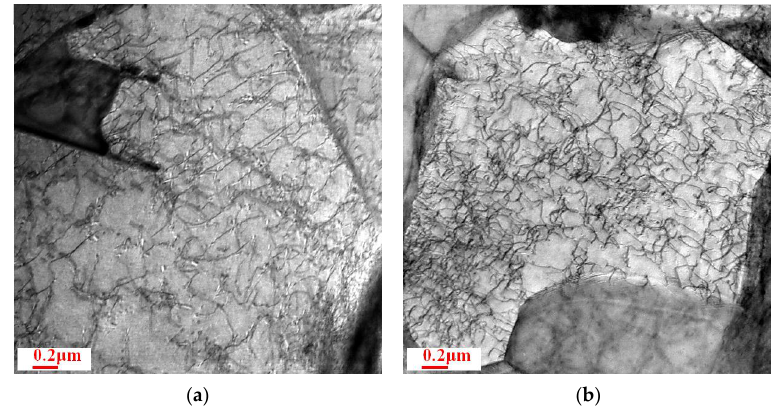
Figure 6. Dislocation distribution in the FZ of TWBs: ( a ) before and ( b ) after the magnetic treatment. In order to exhibit the distribution of dislocations, the enlarged images at local positions A and B are shown at the top right corner of each photograph. FZ: fusion zone; TWBs: laser tailor welded blanks. Figure 7a,b show the microstructures in the HAZ of the non-magnetically and magnetically treated TWBs, respectively. It can be seen that, similar to that of the weld zone, after the magnetic treatment, the dislocation density in the HAZ increased obviously and dislocation nets were formed in some local areas.